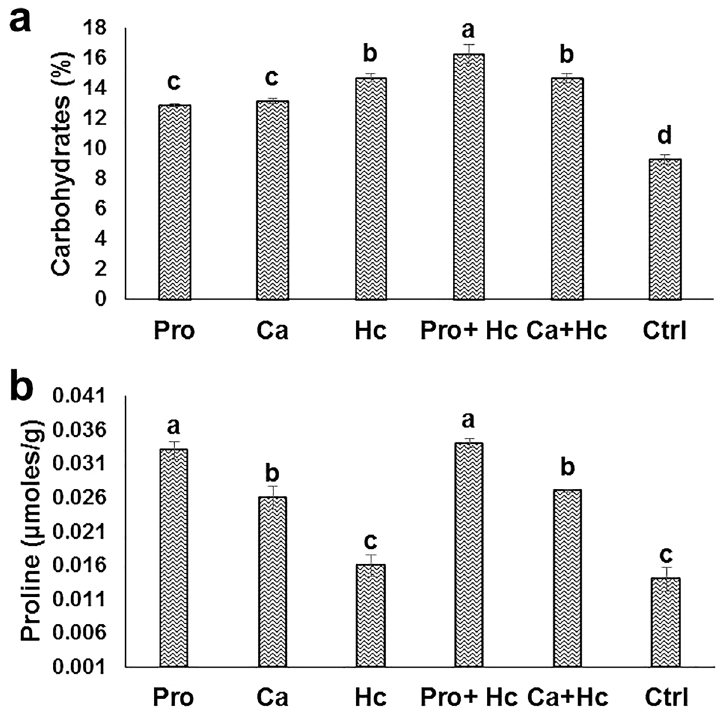
Figure 1. Effect of proline (Pro) and calcium (Ca) as foliar application alone or incombination with humic acid (Hc) as soil application on carbohydrates leaves percent ( a ) and proline ( b ) leaves content (µmoles g −1 ) of ‘Wonderful’ pomegranate trees grown under salt stress conditions. The different letters on the bars in each column represent significant difference at p ≤ 0.05; standard error bars represent standerd error of three replicates. Pro: 5 mM proline alone as foliar application; Ca: 1.5% calcium as foliar application alone; Hc: 15 g humic acid as soil application alone; Pro + Hc: 5 mM porline and 15 g humic acid; Ca + Hc: 1.5% calcium and 15 g humic; Ctrl: control (non